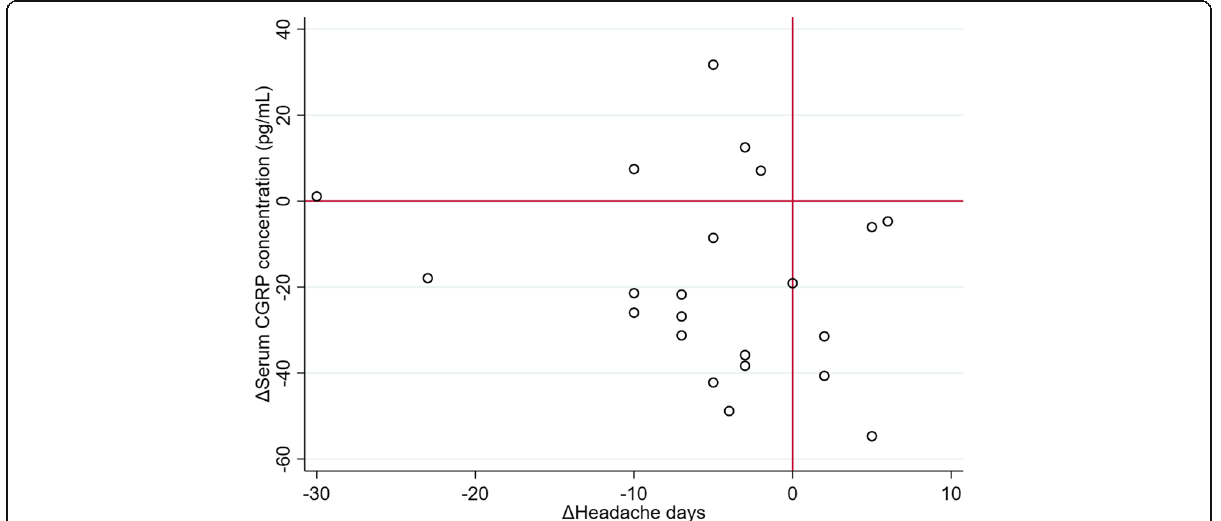
Fig. 5 Correlation between changes in monthly headache days and serum CGRP concentrations before and after 3 months. The right upper and left lower sections indicate positive